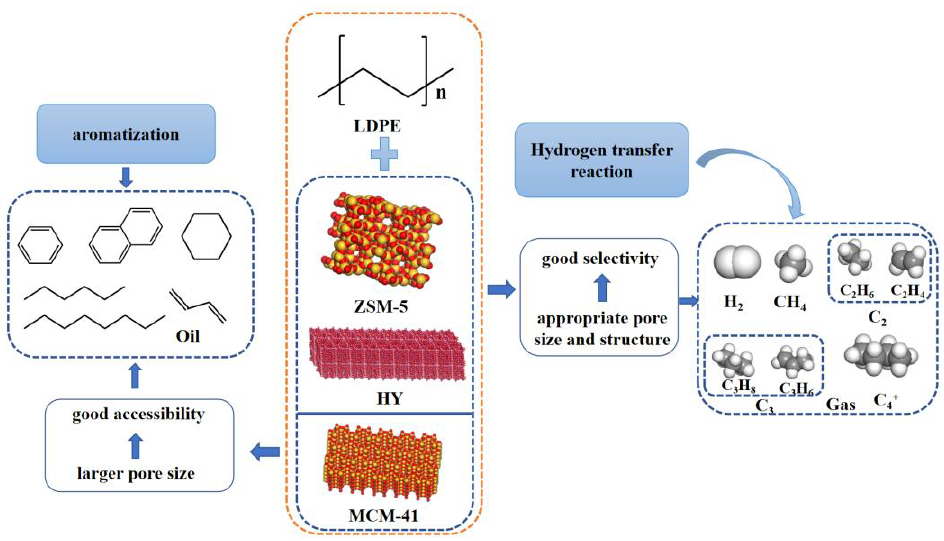
Figure 7. The scheme of catalyst participation in LPDE pyrolysis reaction pathways.